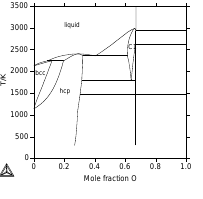
single fcc fcc+fcc fcc+bcc fcc+metal bcc+metal single bcc